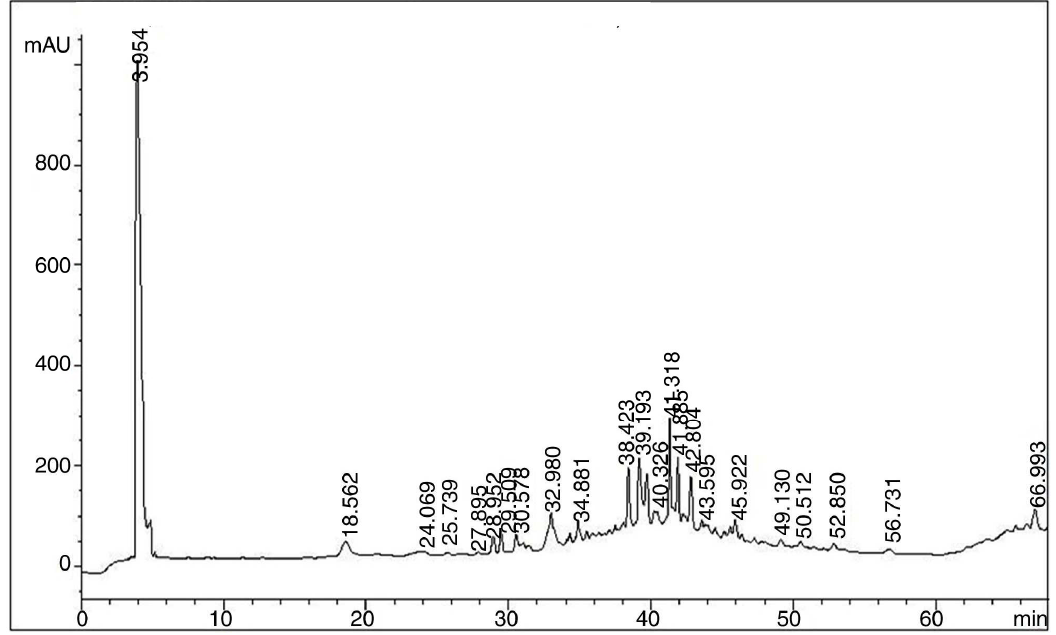
Figure 2. HPLCchromatogram of phenolic andflavonoidsin the extract of C. macrophylla . Figure 2. HPLC chromatogram of phenolic and flavonoids in the extract of C. macrophylla .